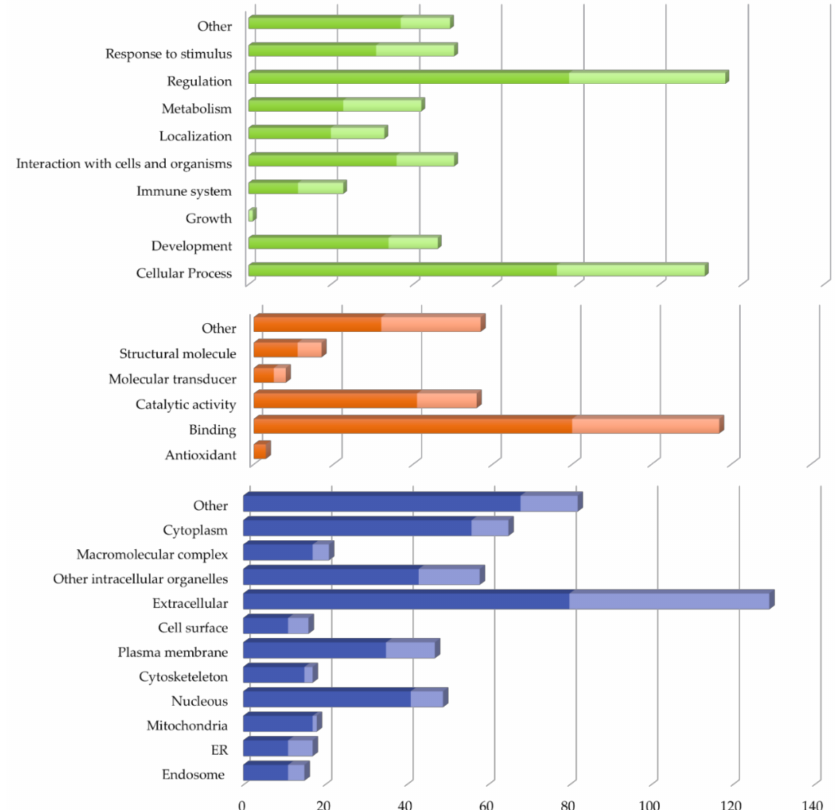
Figure 1. Classification of the 150 proteins found differentially expressed in vitreous of patients with rhegmatogenous retinal detachment in comparison with macular epiretinal membranes samples according to Gene Ontology (GO) terms using STRAP 1.5. GO annotation for biological process, molecular function, and cellular component are represented by green, orange, and blue bars,